Question: Which kind of chart has been used to present this data?
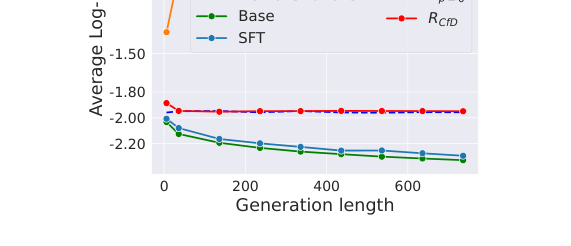
Answer: line